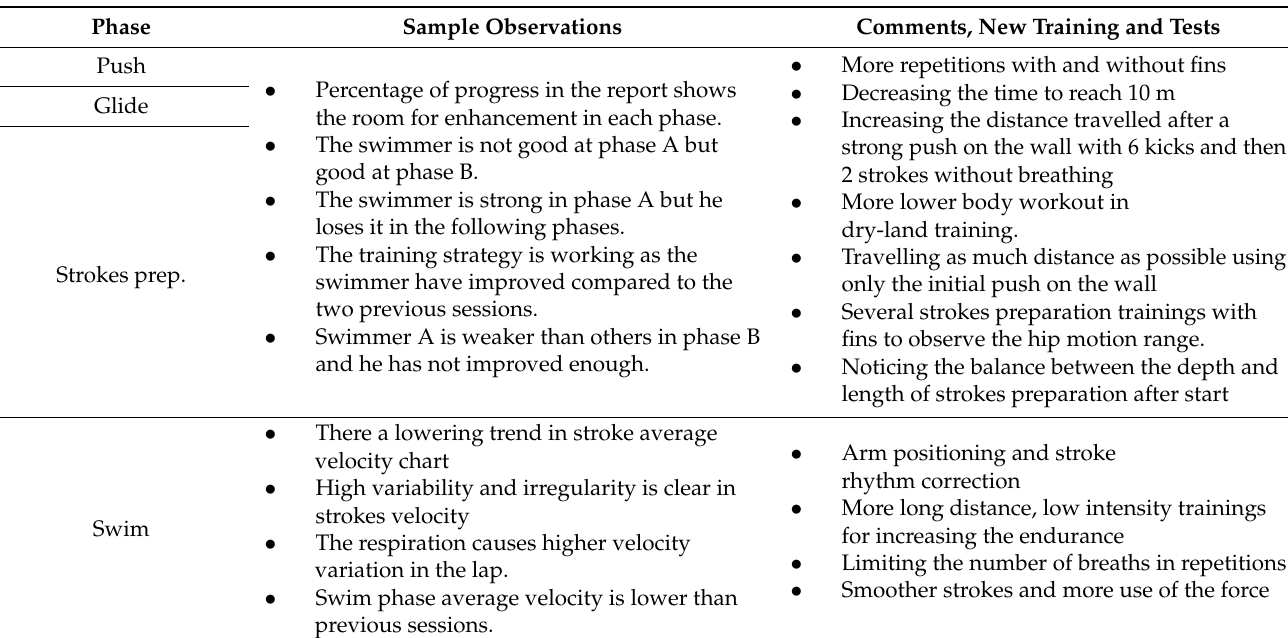
Table A1. Summary of coach observations and training adaptations using SmartSwim. Phase